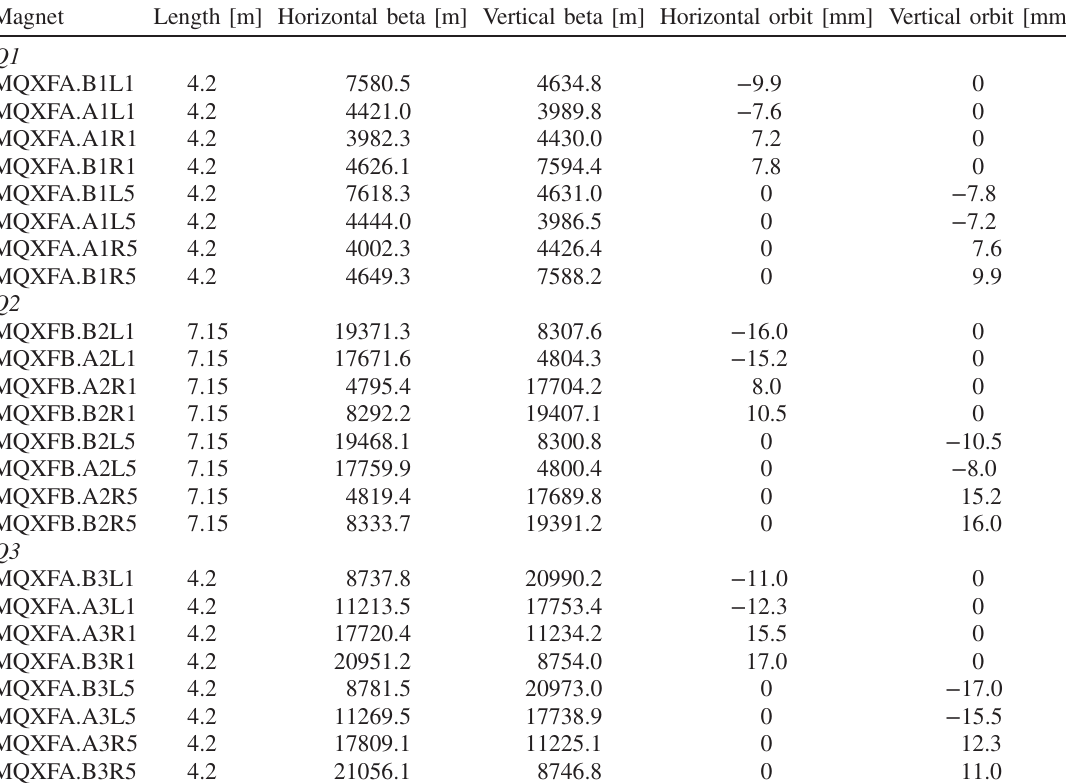
TABLE VII. Main optics parameters for the different triplet magnets, in HLLHCv1.4 optics, round collision with β (cid:1) of 15 cm. Since the parameters change throughout the magnets, the average over the magnet is shown.